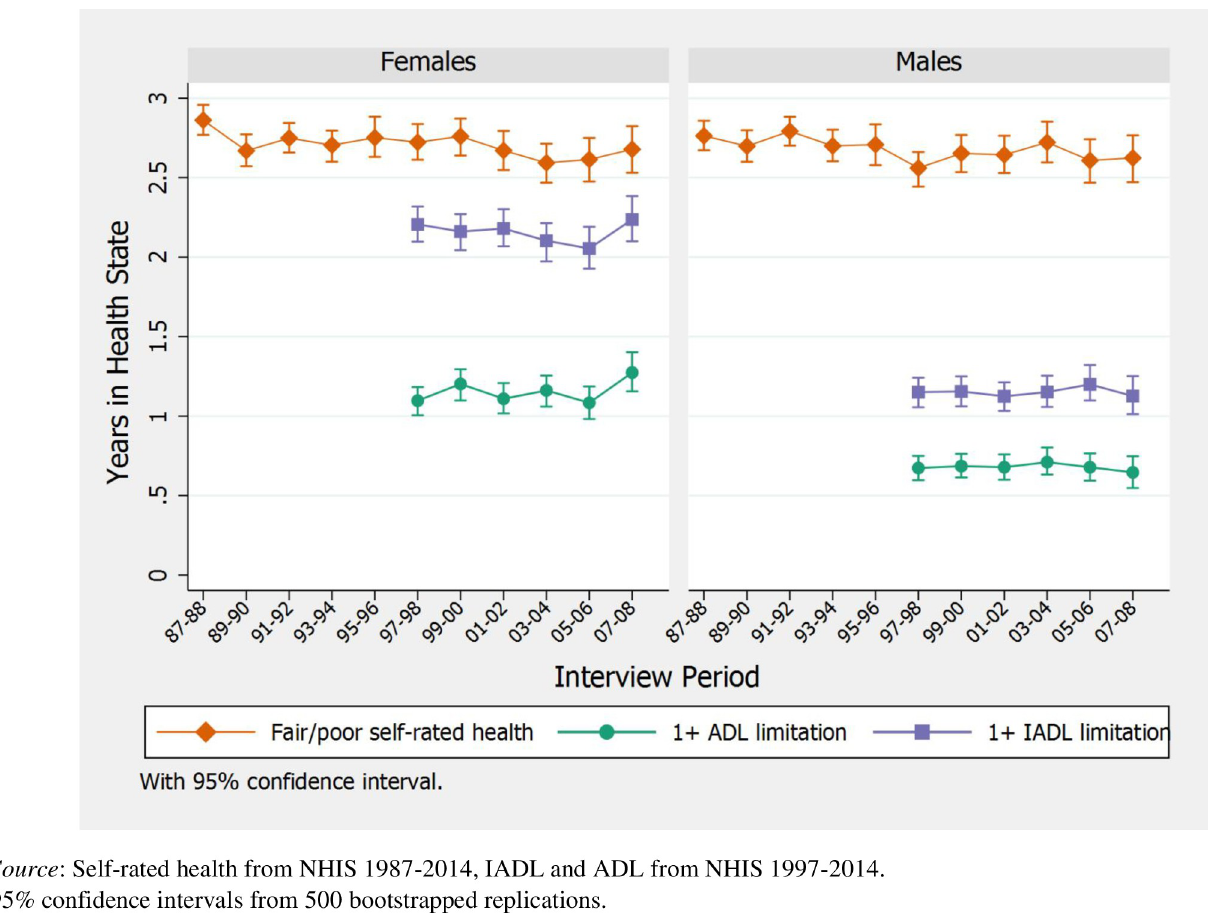
Fig 1. Years out of last six years of life spent in given health state, over time (with 95% confidence intervals).